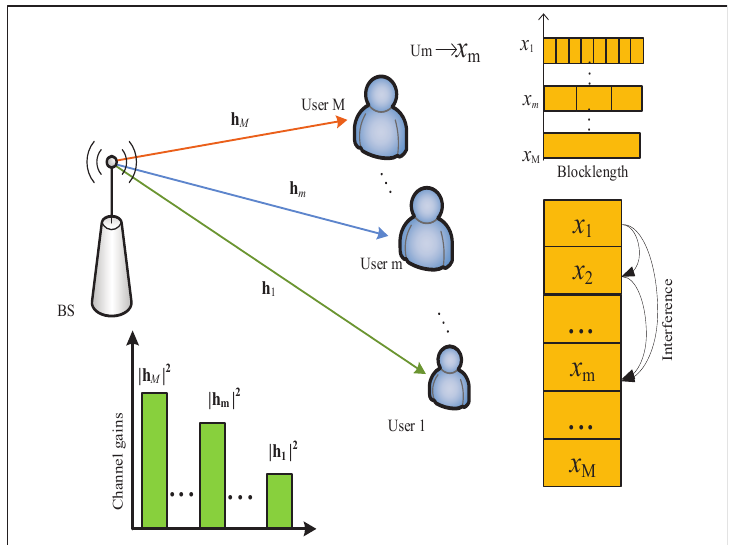
Figure 1. Illustration of a downlink NOMA system with short packet